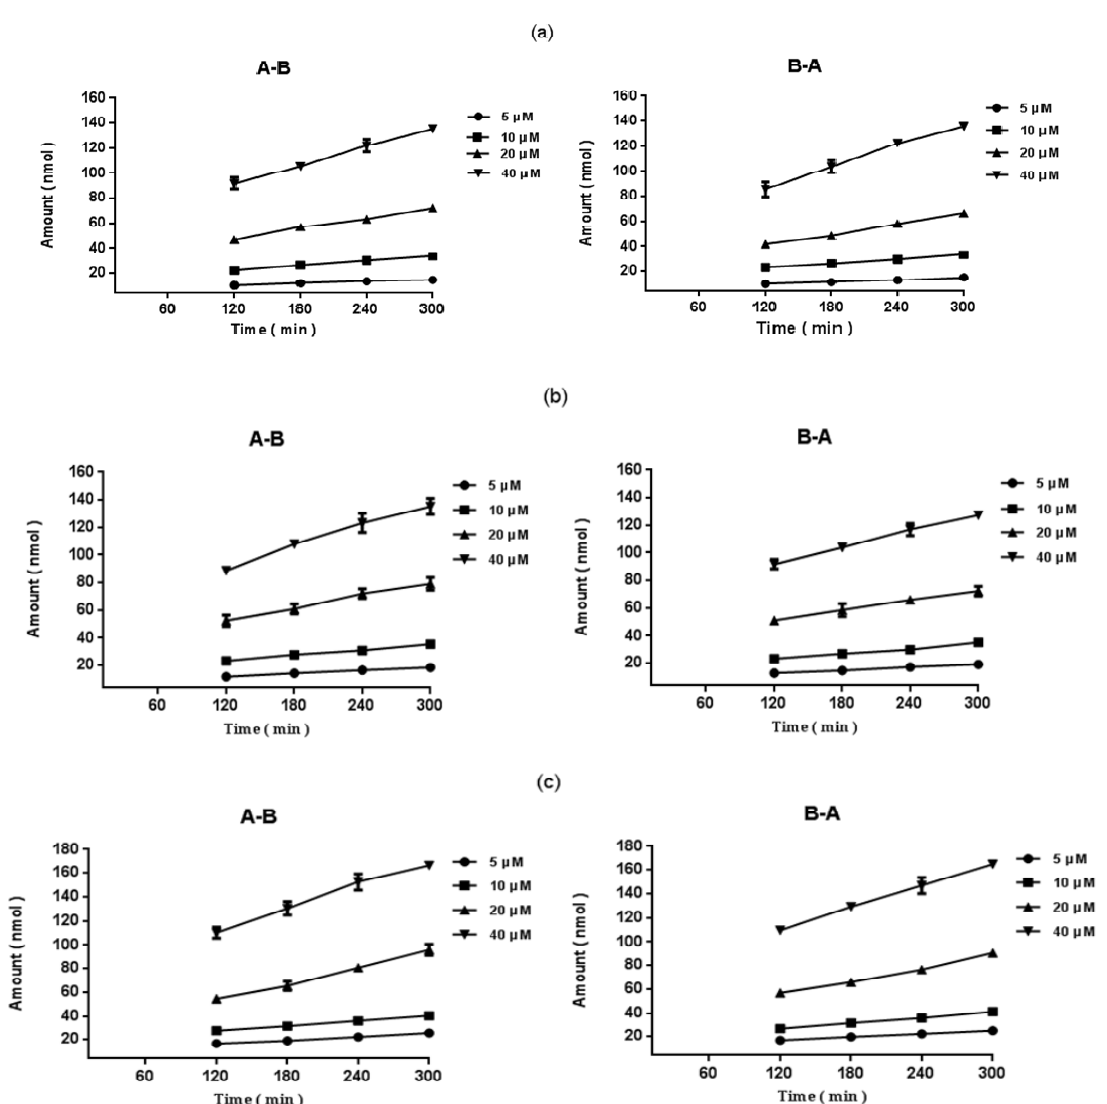
Figure 3. Accumulation of epimedins A, B, and C in Caco-2 cells with time. Caco-2 cell monolayers were incubated with different concentrations of epimedins A, B, and C in the apical to basolateral (A-B) and basolateral to apical (B-A) directions for 2–5 h. Each data point is the average of three determinations, and the error bars represent the standard deviation of the mean. ( a ) Epimedin A; ( b ) Epimedin B; and ( c ) Epimedin